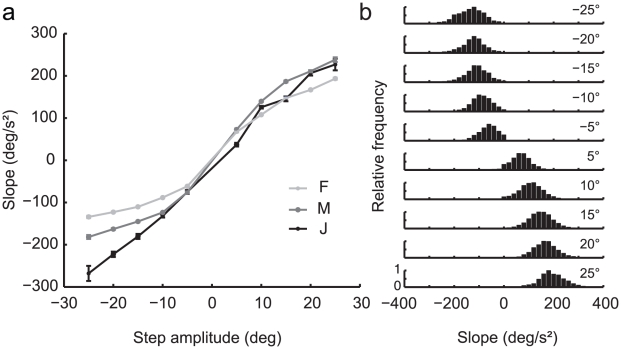
Initial acceleration as a function of step amplitude.a) Mean slope of the initial response by monkey and step amplitude. The slope of the response corresponds to the initial acceleration of the monkey's turn (see Methods). Error bars represent the standard error of the mean. b) Distribution of slopes for monkey F by step amplitude. Similar results were found for monkeys J and M.